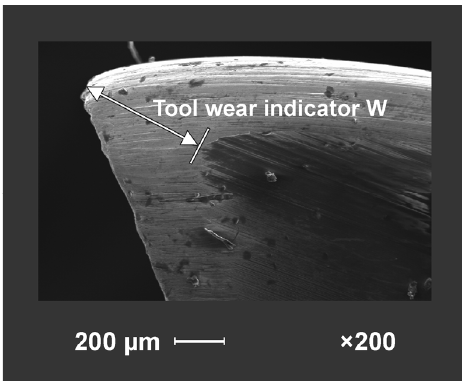
edge of the drill (mm).